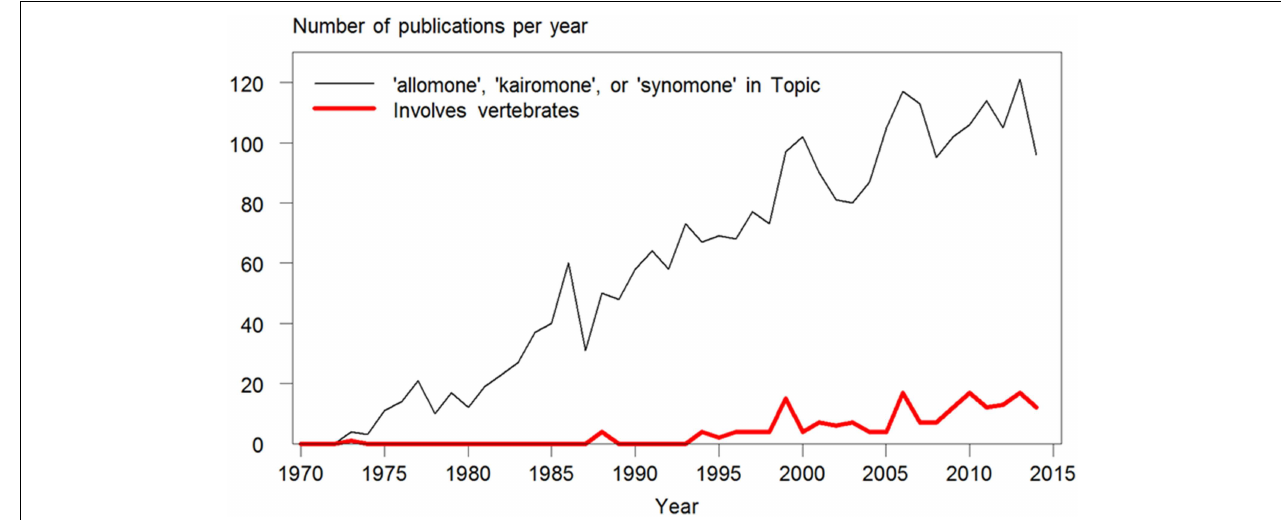
FIGURE 1 | Number of publications per year containing the terms allomone, kairomone, or synomone in their topic. The narrow, black line shows their use overall since their coinage in the 1970’s ( N = 2635 publications) found in a search made in January 2015 in Topic (which includes words in title, keywords, and abstract) in Web of Science ™ (ver. 5.16.1; Thomson Reuters © 2015). The bold, red line shows the number of publications among these, which includes